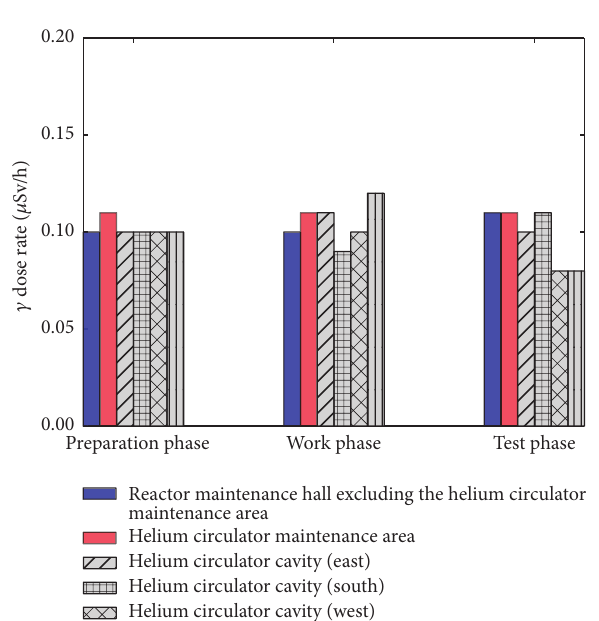
Figure 5: Average 𝛾 dose rate levels of primary work places in the preparation, work, and test phases.